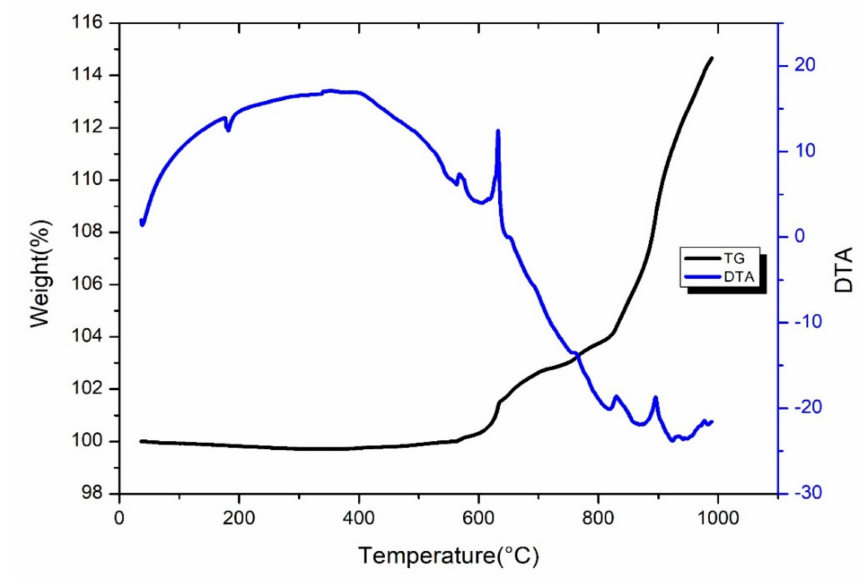
Figure 9. TG/DTA of PV ribbon (25–1000 ◦ C, 10 K/min,